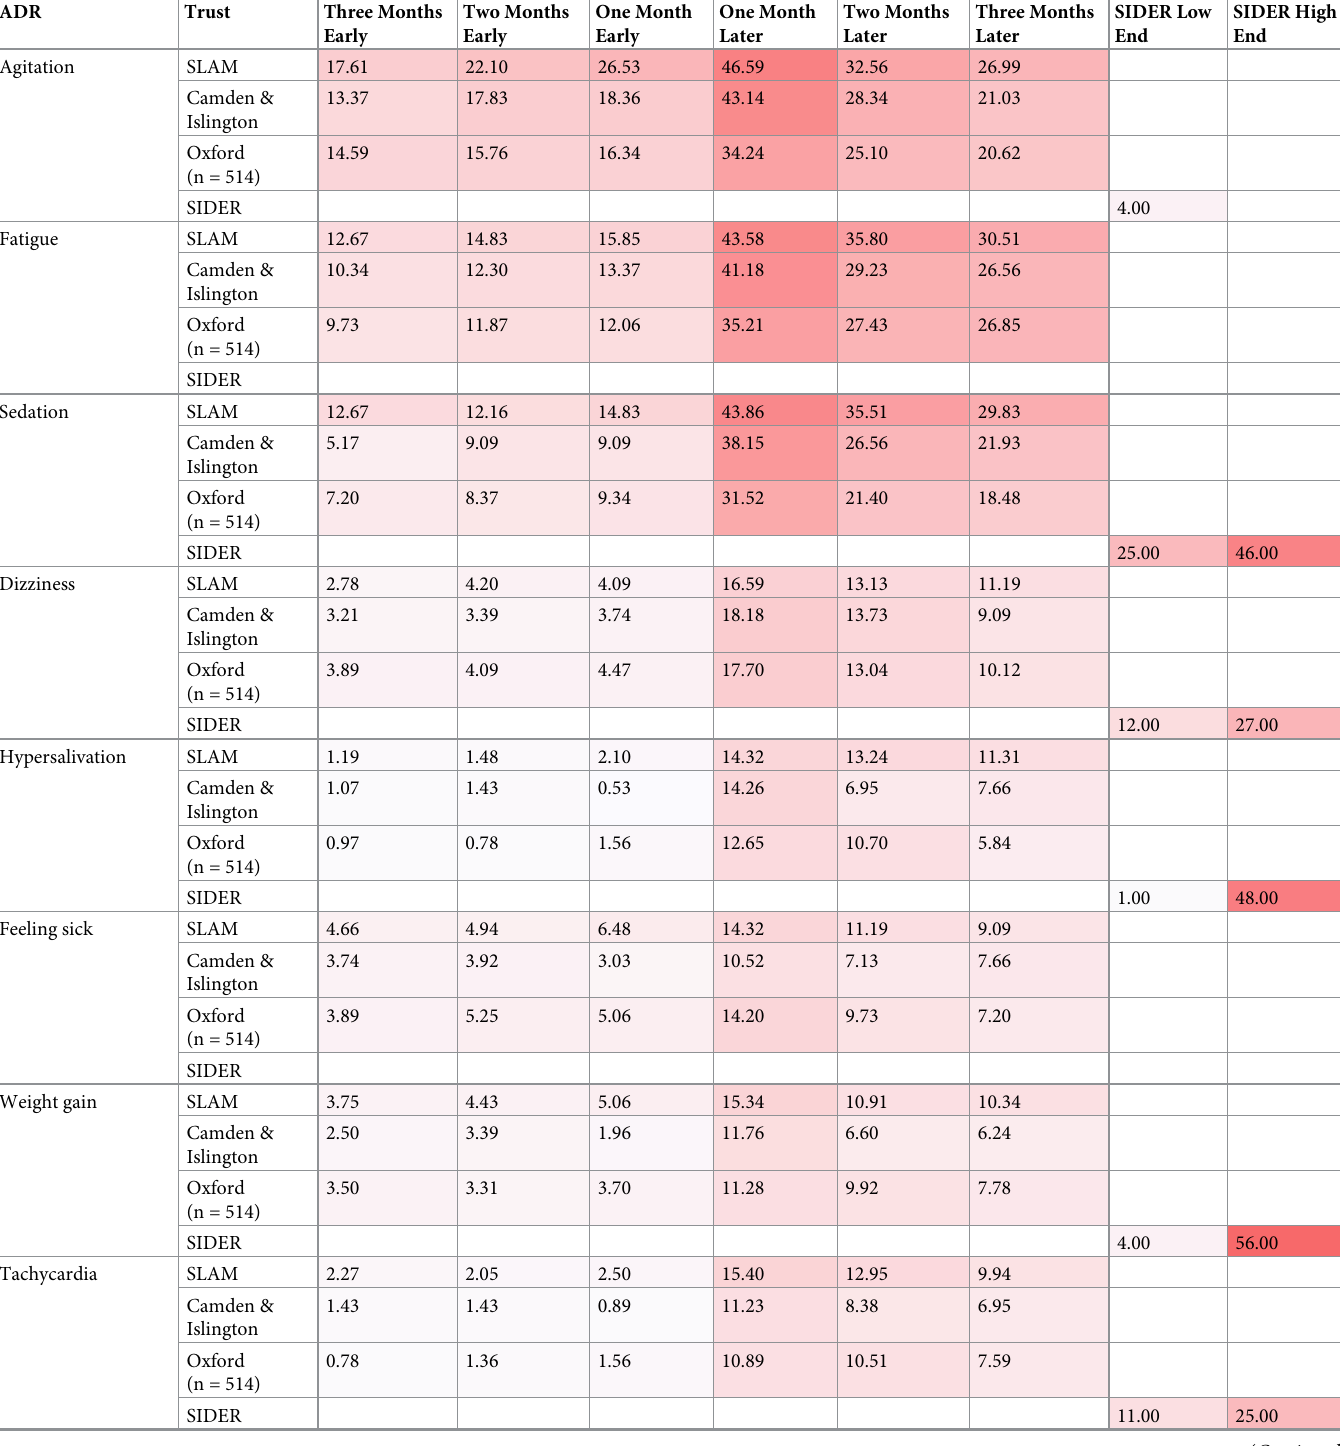
Two Months One Month One Month Two Months Three Months SIDER Low SIDER High Early Early Early Later Later Later End End